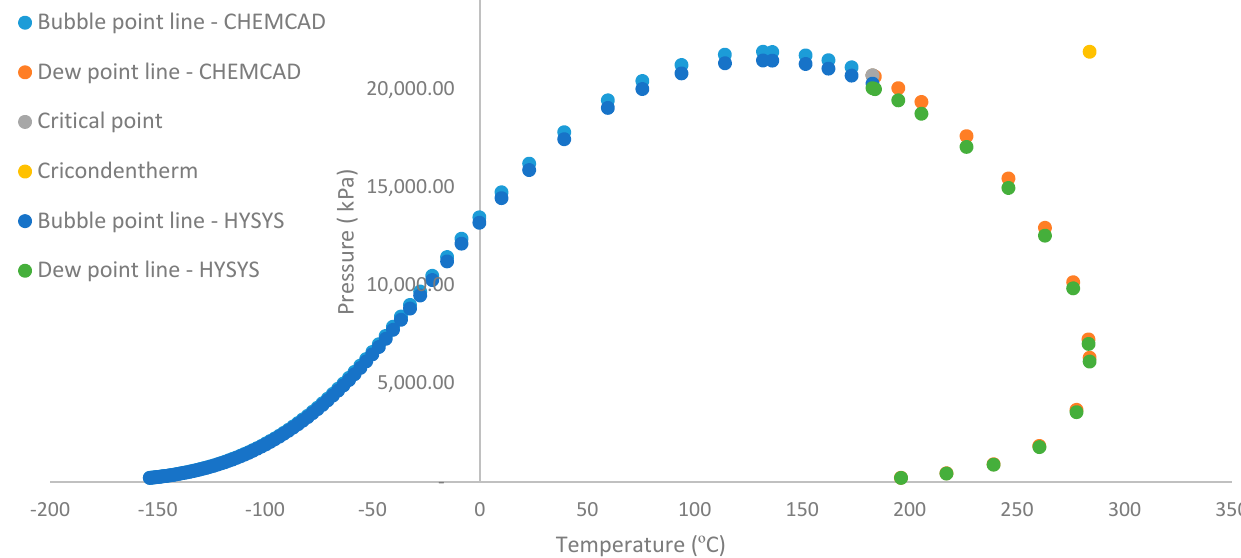
Figure 5. Feed stream phase envelope drawn by HYSYS and CHEMCAD.